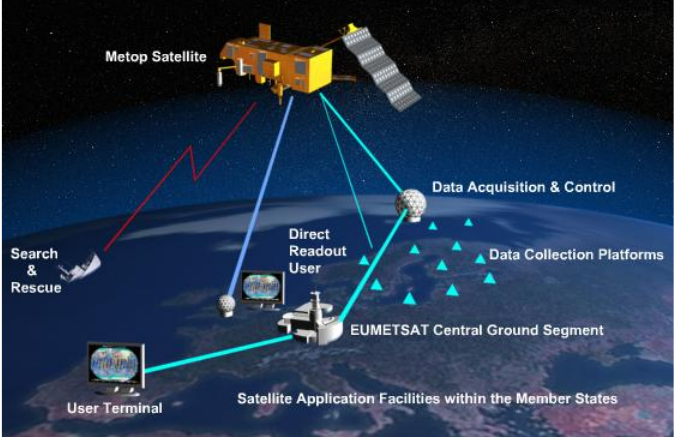
Figure 1. EPS program elements. The space component comprises the MetOp-A, MetOp-B, and MetOp-C satellites, while the ground component includes reception and operating